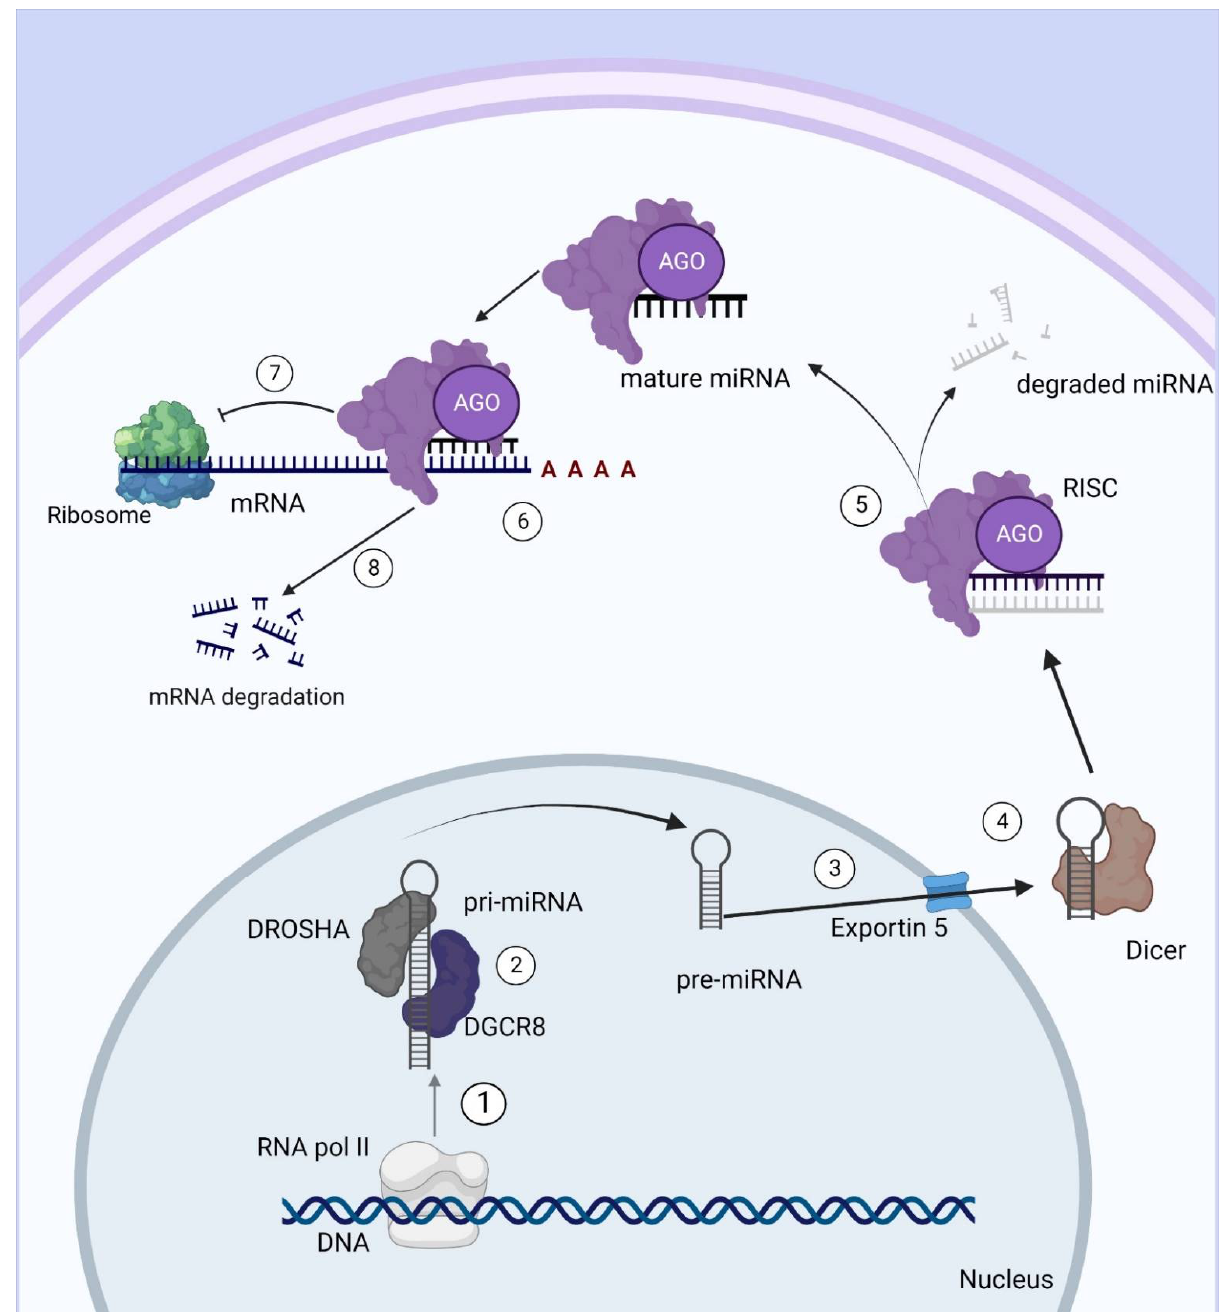
Figure 1. Classical pathway: miRNA synthesis. (1) miRNA is mostly transcribed by RNA polymerase II through genomic regions. (2) pri-miRNA, a hairpin sequence, is then processed by DROSHA and DGCR8 proteins, which results in pre-miRNA. (3) pre-miRNA is transported to the cytoplasm through Exportin 5. (4) In the cytoplasm, pre-miRNA is processed by Dicer, which removes the terminal loop generating a 19-25nt miRNA. (5) miRNA is incorporated into the RNA-inducing silencing complex (RISC) with Argonaute (AGO) protein that retains one of the strands, the mature miRNA, while the other strand is degraded. (6) Mature miRNA associated with AGO and RISC binds its seed sequence in the target miRNA response element (MRE) in the mRNA. After binding, mRNA translation might be inhibited by two main mechanisms. (7) RISC represses translation or (8) RISC leads to mRNA degradation.